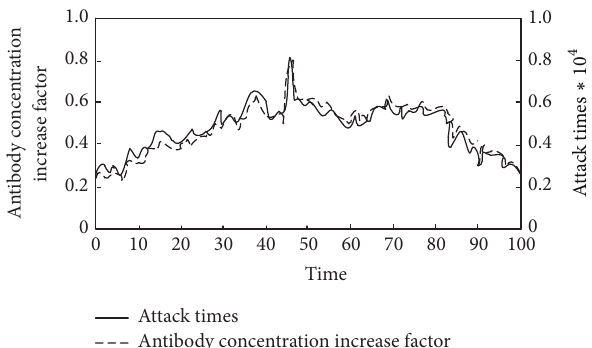
Figure7:Host 𝑠 1 ofattacksandantibodyconcentrationincreasefac- tor.